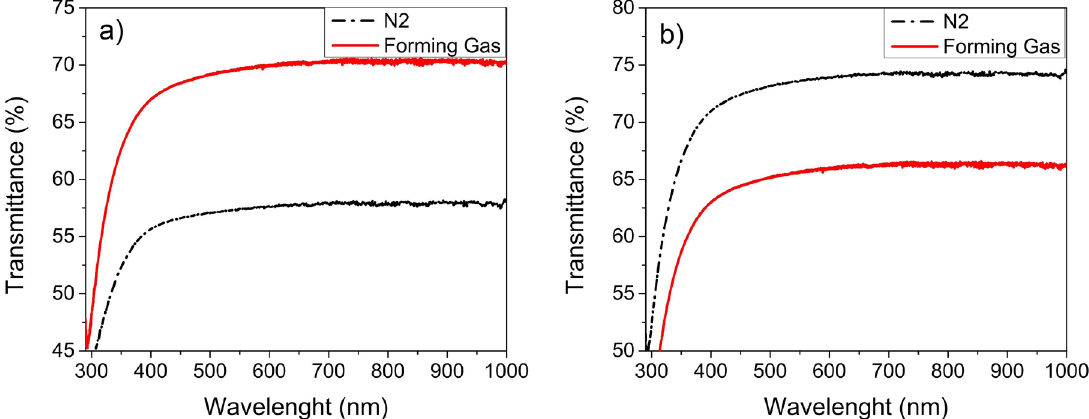
Figure 4. The transmittance of ATO thin films annealed in nitrogen and Forming gas atmospheres a) 325°C and b)